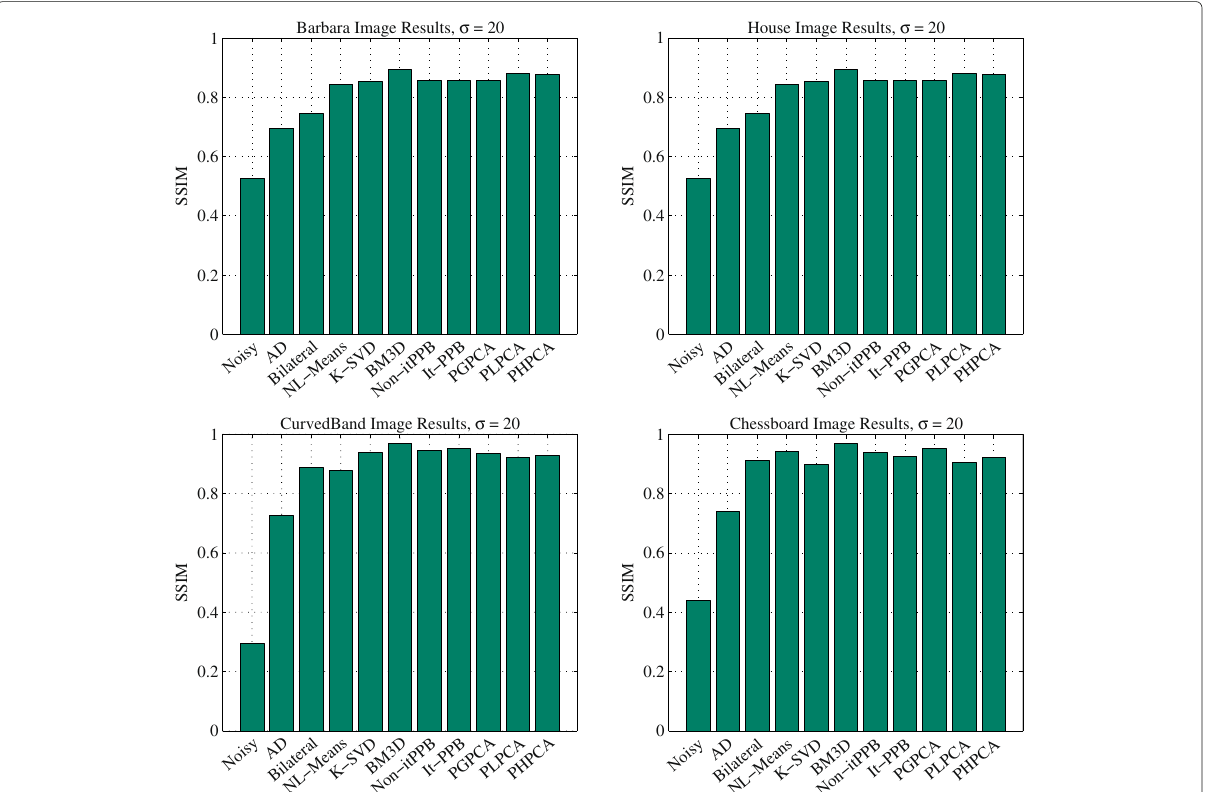
Fig. 13 The performance charts: four charts summarize the performance of the denoising methods for the four images when the noise is low (σ = 20 )